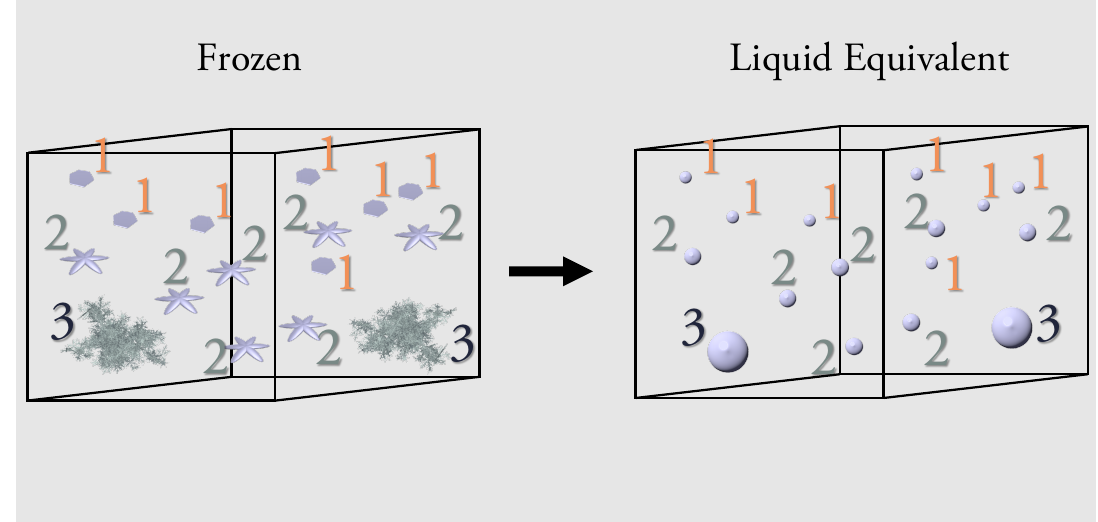
Figure 1. Schematic diagram to illustrate the conversion of the measured solid phase size distribution of particles to the liquid equivalent. The box is an instantaneous sample volume, and the particle diagrams are from ARTS ([70] https://zenodo.org/record/1175573). Each number corresponds to the same